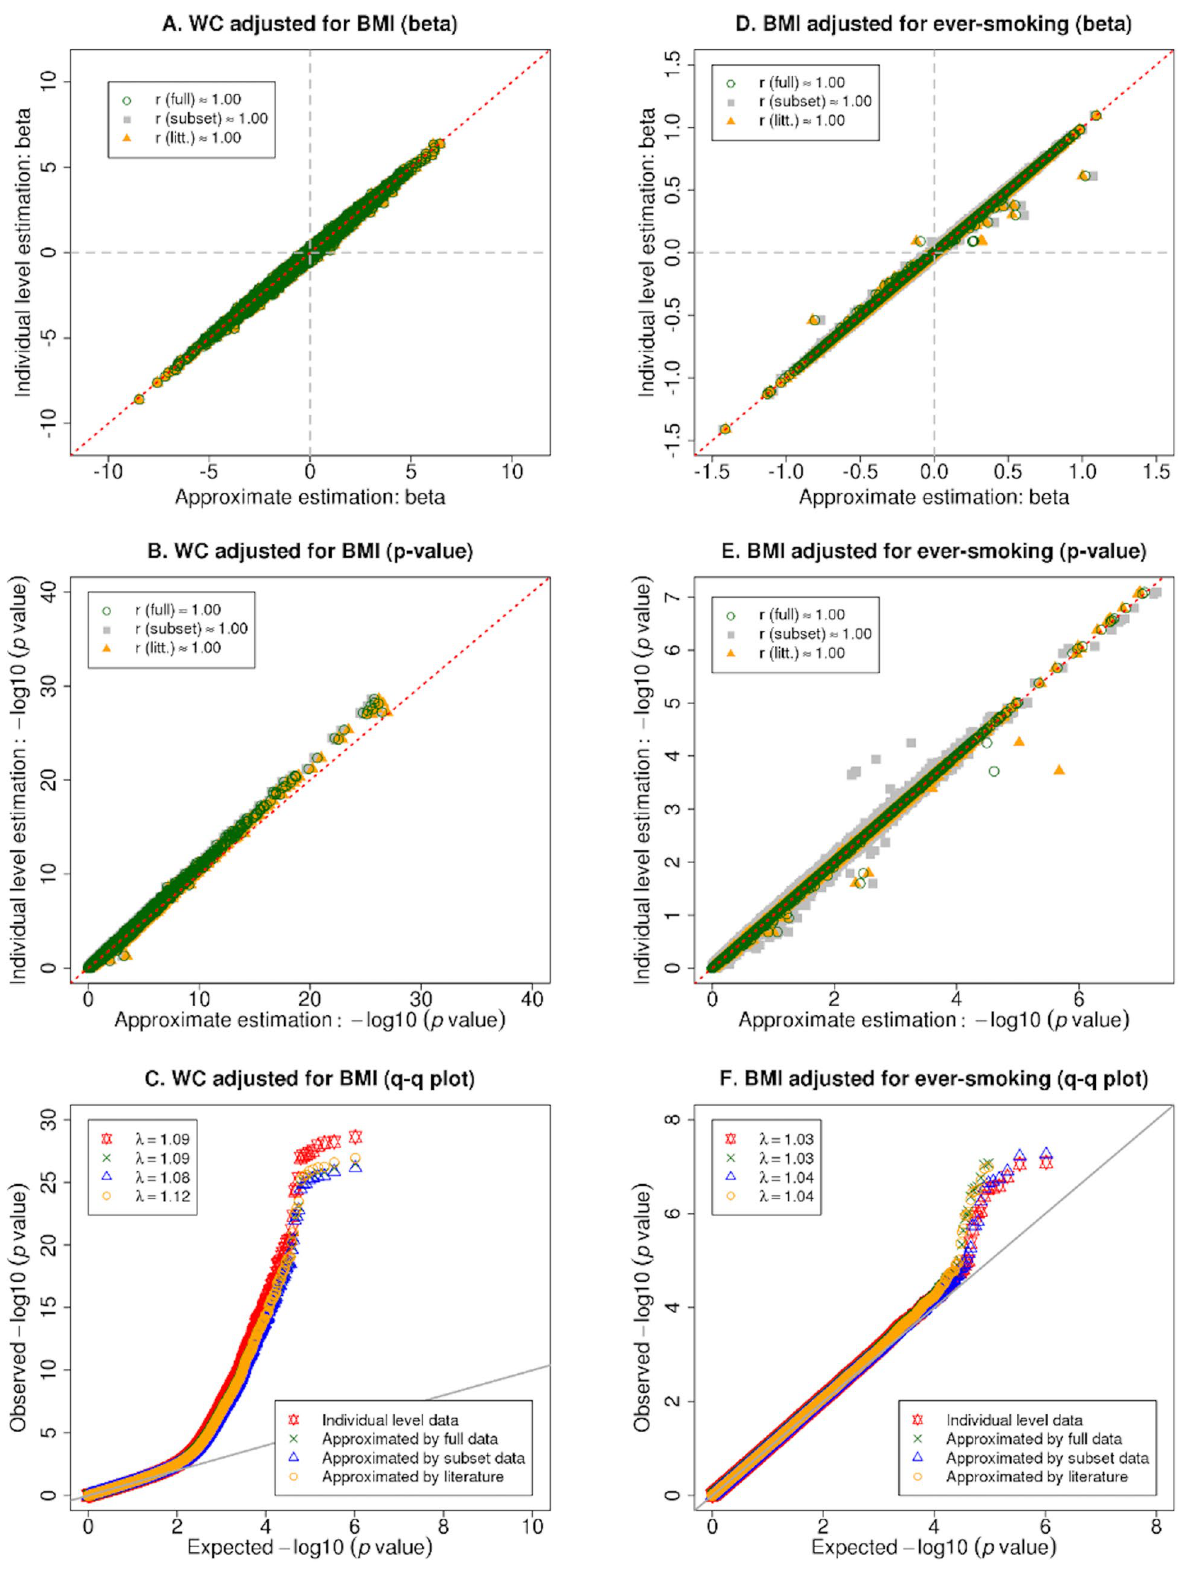
Figure 2. Estimated effect sizes, − log10 (p-values) and quantile–quantile plots for GWAS with continuous outcomes measured in the Framingham Heart Study. Panels ( A – C ) present the estimated effect sizes, − log10 (p-values), and quantile–quantile plot (q-q plot), respectively, for GWAS results from analyzing waist circumference (WC) adjusted for body mass index (BMI); panels ( D – F ) present the estimated effect sizes, − log10 (p-values), and q-q plot, respectively, for BMI adjusted for